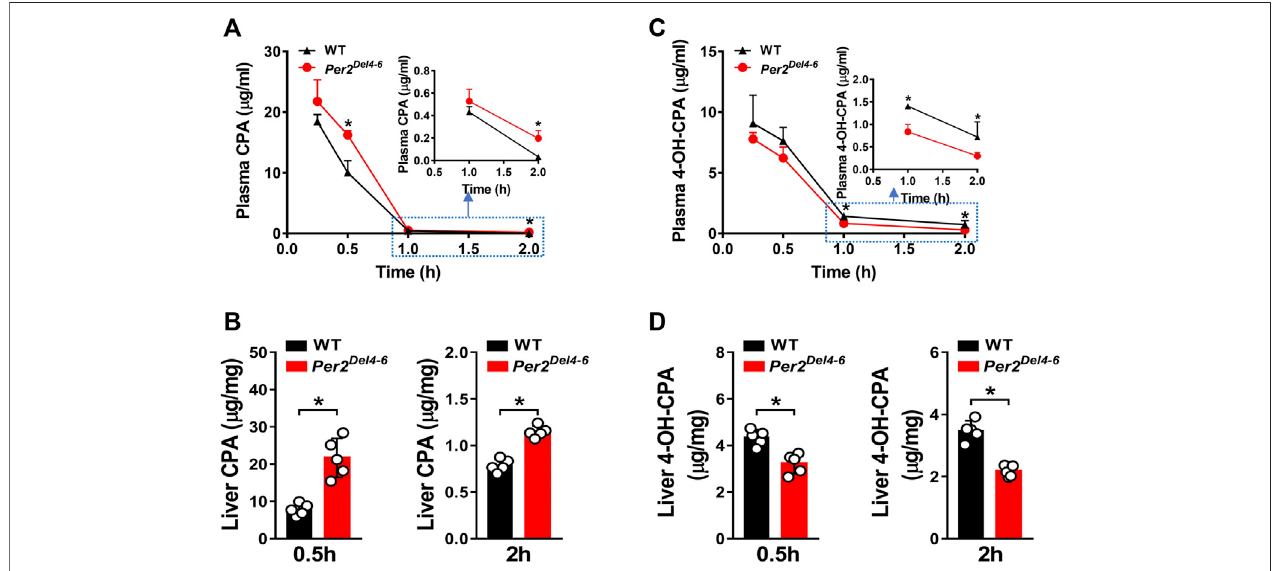
FIGURE4| CharacterizationofCPAmetabolismandpharmacokineticsinPer2 Del4-6 mice. (A) PlasmaconcentrationsofCPAin Per2 Del4-6 andWTmiceatdifferent time points after CPA treatment (i.p., 100 mg/kg). (B) Plasma concentrations of 4-OH-CPA in Per2 Del4-6 and WT mice at different time points after CPA treatment. (C) LiverconcentrationsofCPAin Per2 Del4-6 andWTmiceat0.5and2 hafterCPAtreatment. (D) LiverconcentrationsofCPAin Per2 Del4-6 andWTmiceat0.5and2 hafter CPA treatment. Data are mean ± SD ( n (cid:1) 5). * p < 0.05 (t test).